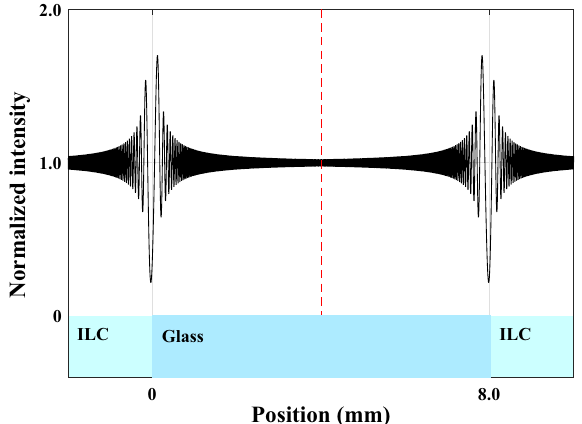
Figure 8. Both the ordinary and extraordinary LCs lose their only remaining directional order and transform to the isotropic LC (ILC) for a bulk NLC at temperatures higher than the phase transition temperature T C . In this case, the light intensity patterns diffracted from the two phase steps are identical and symmetric with respect to an axis that runs parallel to the z axis and through the center of the glass plate (dashed line). However, with confinement substrates, it is only conceivable to see identical and symmetrical fringes by assuming that the nchoring effect is negligible and/or that LC is at a temperature high enough to be far from T C .